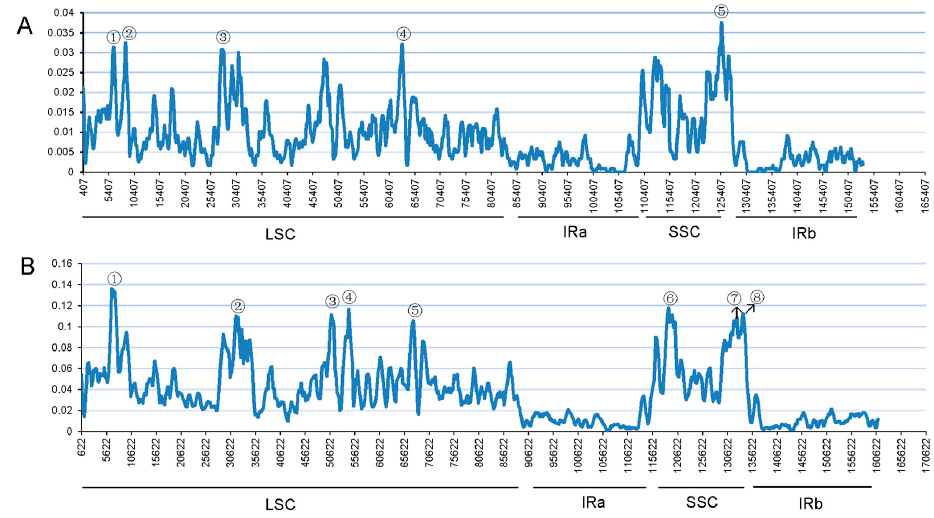
Figure 7. Sliding window analysis of the whole chloroplast genomes. Window length: 800 bp; step size: 200 bp. X-axis: position of the midpoint of a window. Y-axis: nucleotide diversity of each window. ( A ) Pi among three Papaver species. ( B ) Pi among three Papaver species and C. hylomeconoides . ① – ⑧ indicate mutational hotspots and highly divergent loci.